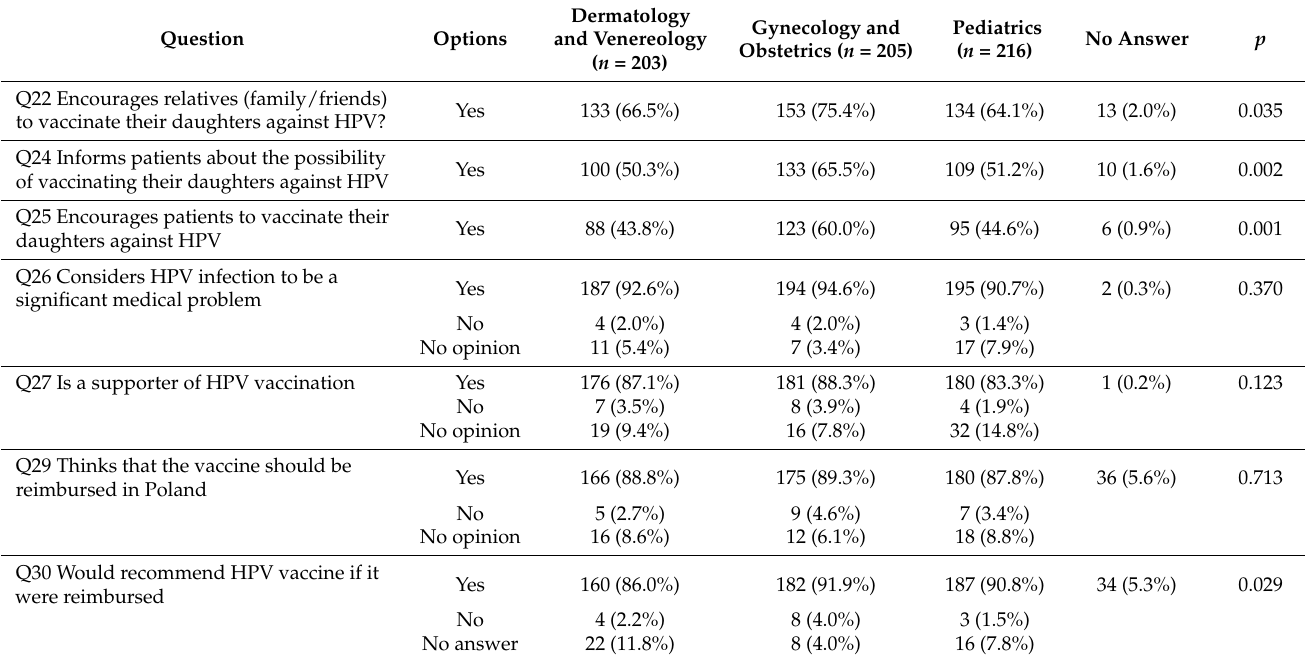
Table 8. Doctors’ attitude to HPV vaccinations depending on specialization.